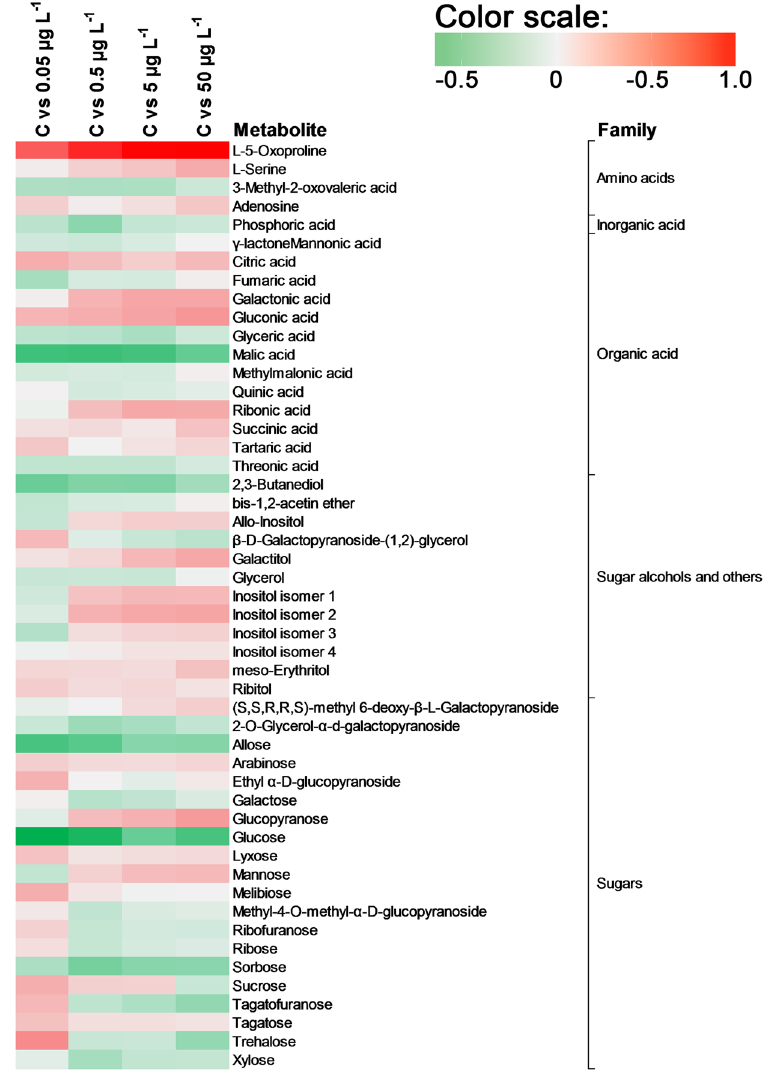
Figure 3. Heat map of changes in the levels of 50 metabolites in response to the CEC exposure concentration compared to unexposed lettuces (C). The log 10 fold change in abundance ratios (see Eq. 1) are shown in Table S8. Red indicates an up-regulation effect, whilst green indicates a down-regulation